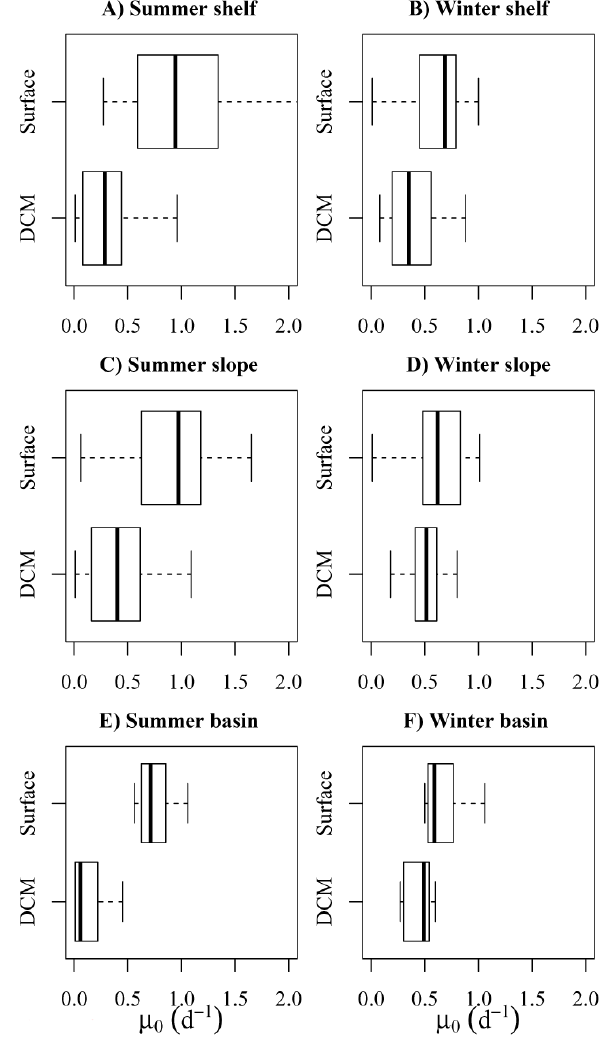
Fig. 4. Box plots of phytoplankton instantaneous growth rate ( µ 0 )